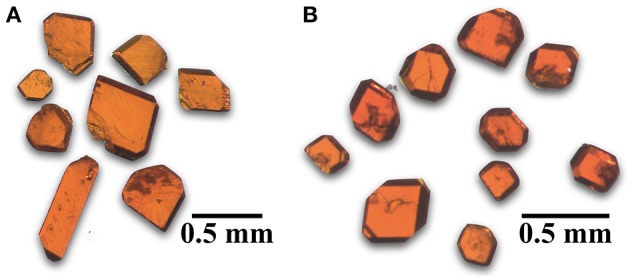
Optical images of orange-red tablet shaped single crystals of (A) Cs11[(UO2)12(PO4)3O13] (1) and (B) Rb11[UO2)12(PO4)3O12F2] (2).